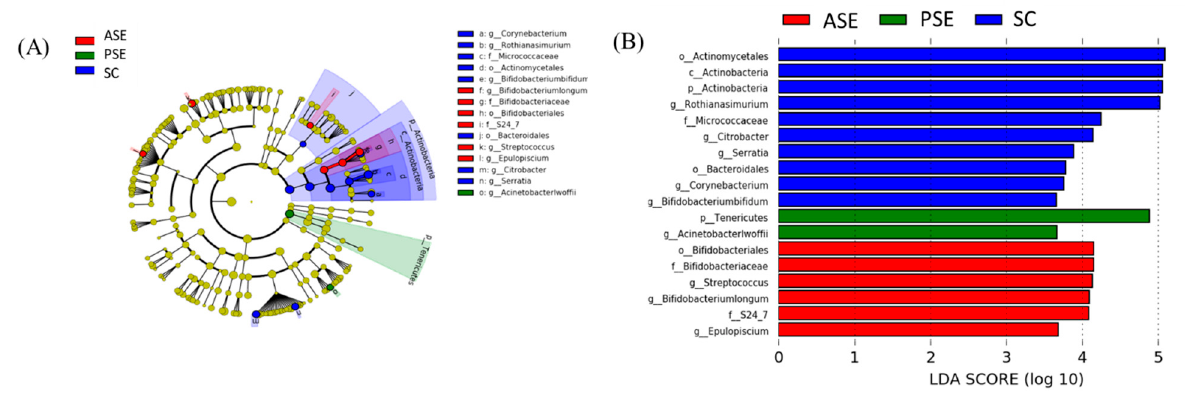
Figure 7. Effects of synbiotics on taxonomies of the fecal microbiotic compositions in rats with chronic ethanol feeding. ( A ) A linear discriminant analysis of the effect size (LEfSe) of the most significant abundance differences in the fecal microbiota among the SC, PSE, and ASE groups ( n = 6). ( B ) Bacteria meeting the linear discriminant analysis (LDA) threshold ( ≥ 2.5) ( n = 6).